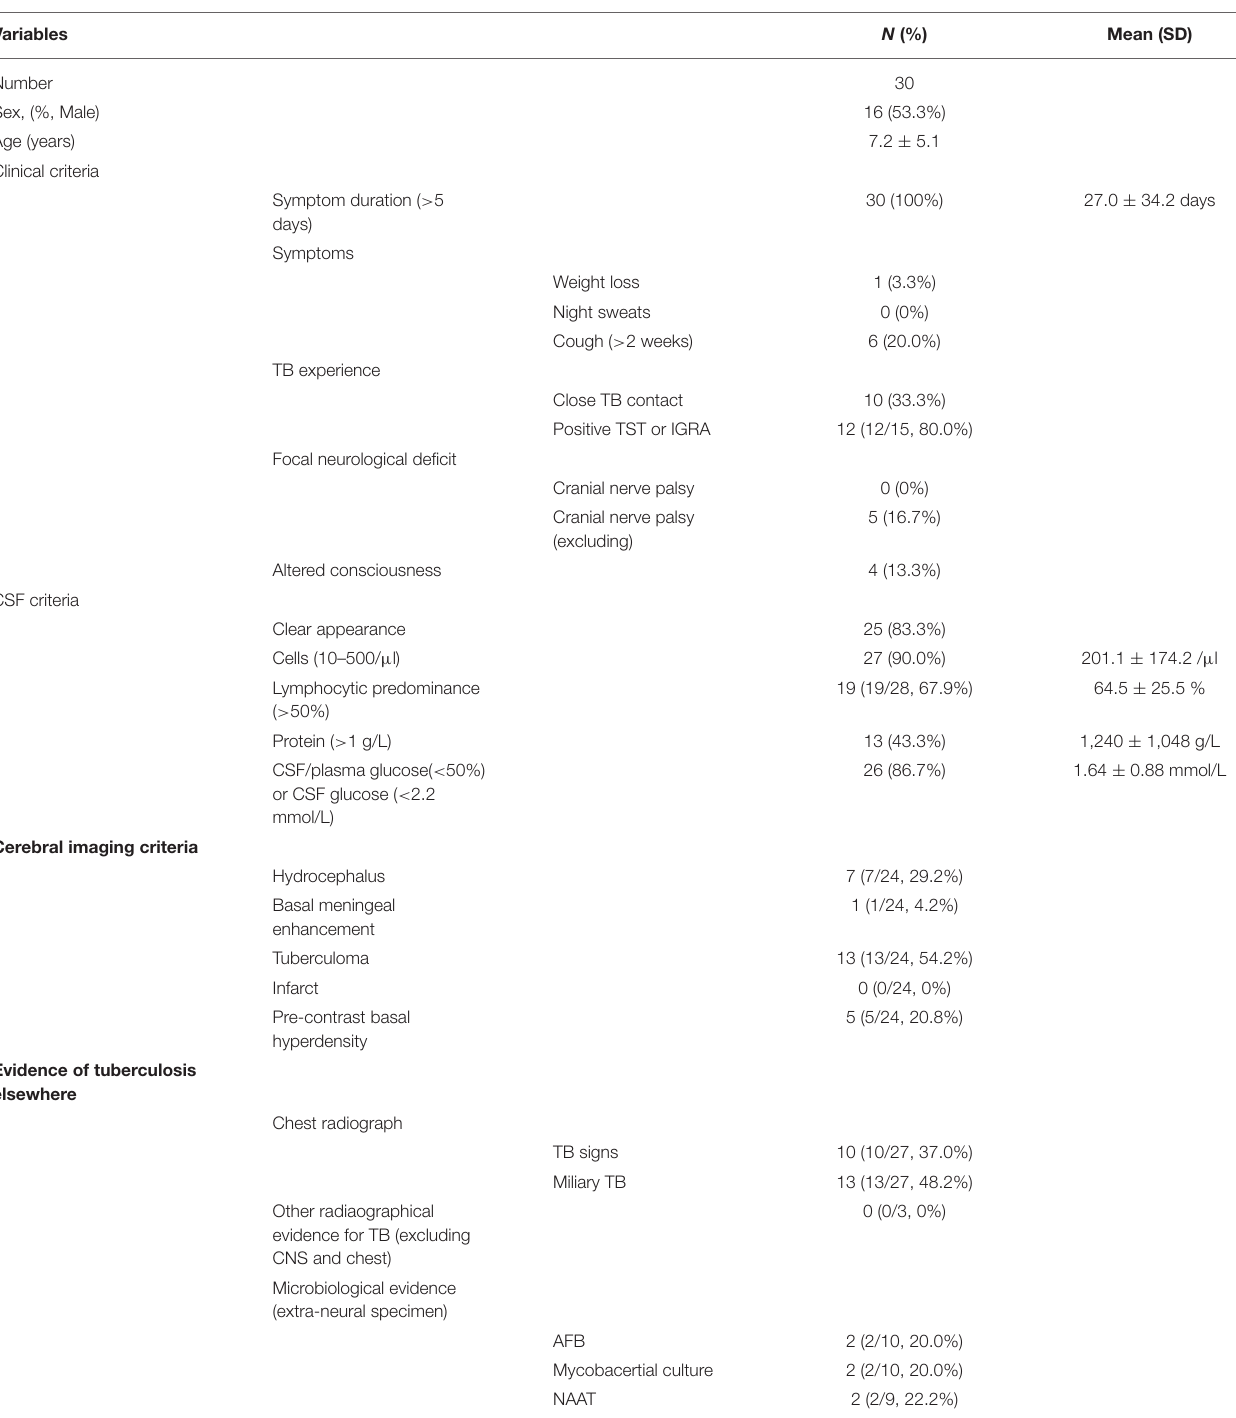
TABLE 2 | The clinicopathological of confirmed pediatirc tuberculous meningitis in Shandong, China.